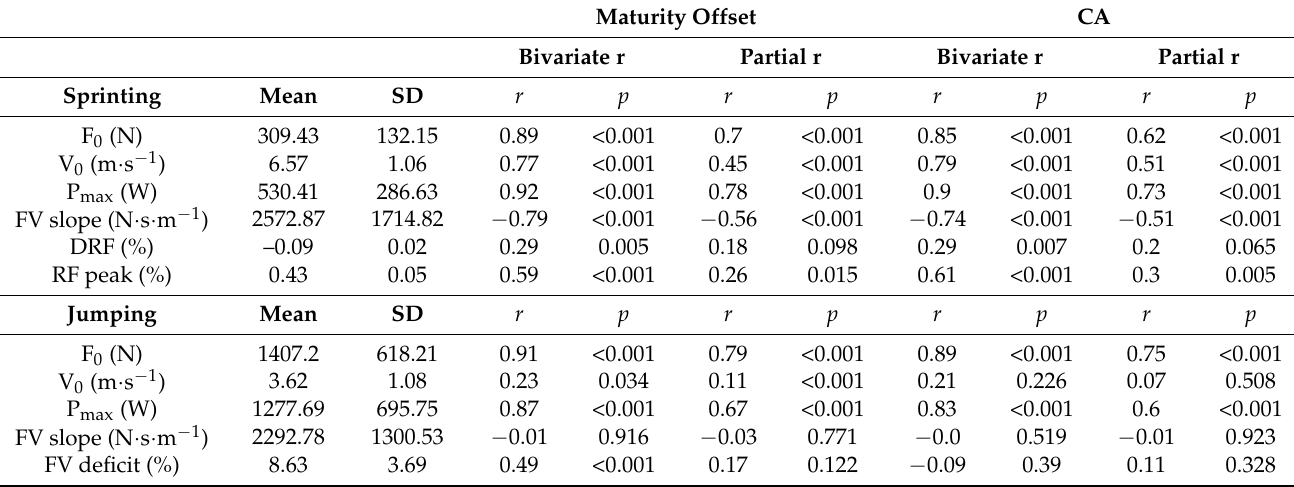
Table 2. Descriptive statistics of parameters of the force-velocity profiles in sprinting and vertical jumping, and correlation coefficients and p -values between these parameters, either not controlling for or considering the influence of training experience and body size, and both maturity offset and chronological age